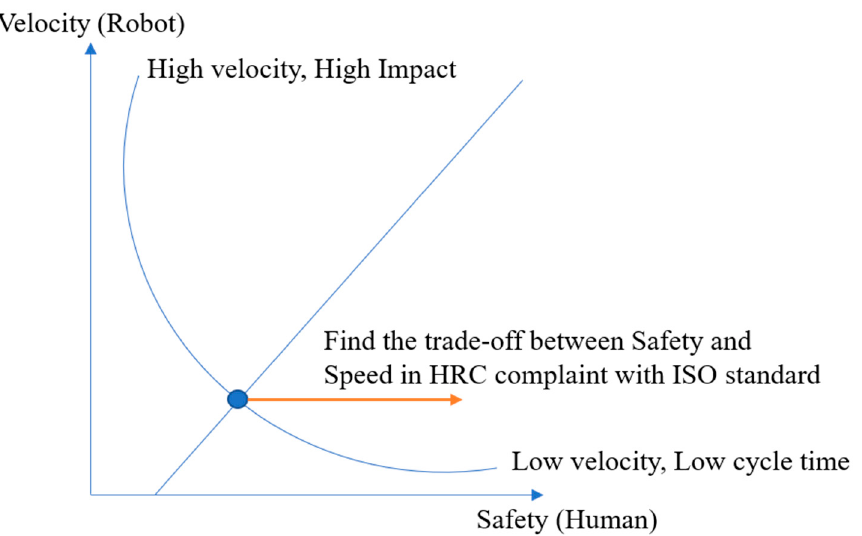
Figure 11. The trade-off between the safety and the velocity of the robot joint in HRC to benefit both the production and safe HRC. DT-HRC can be used to create a model that complies with the ISO guidelines as well as optimize the parameters of the robot in real-time. Various parameters are continuously monitored and measured to meet ISO standards.